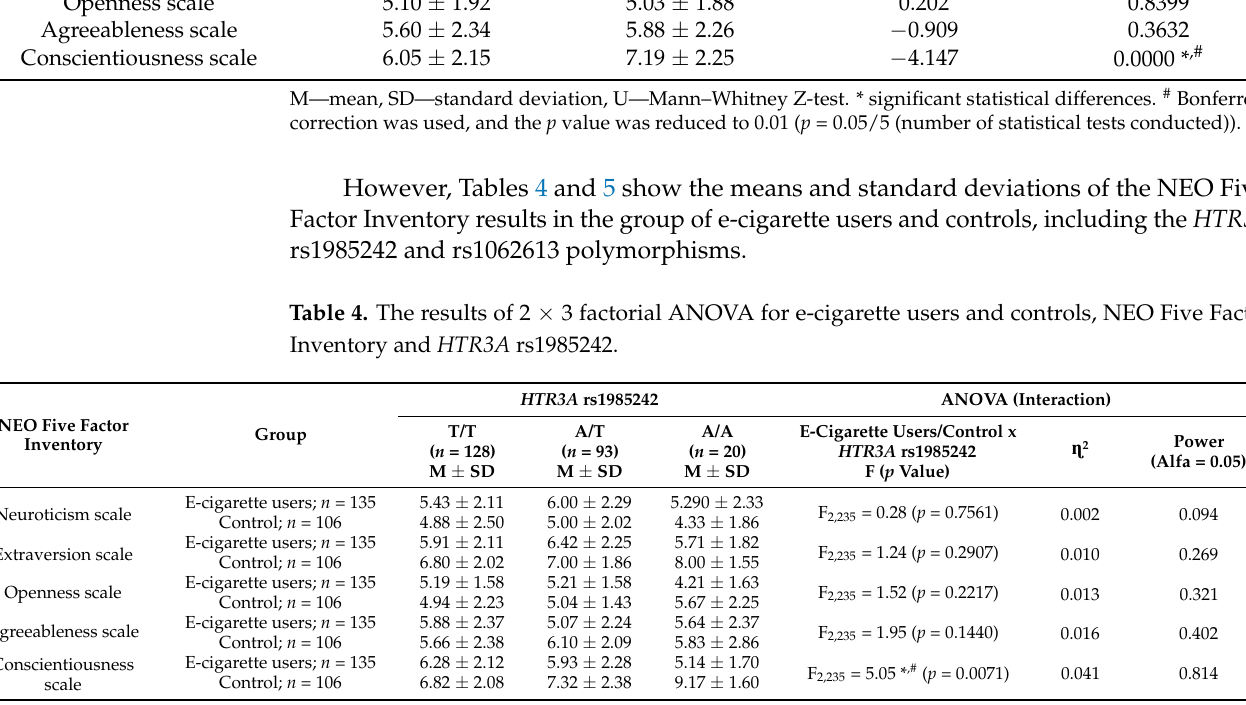
Table 3. Analysis of NEO Five Factor Inventory results in e-cigarette users and controls.